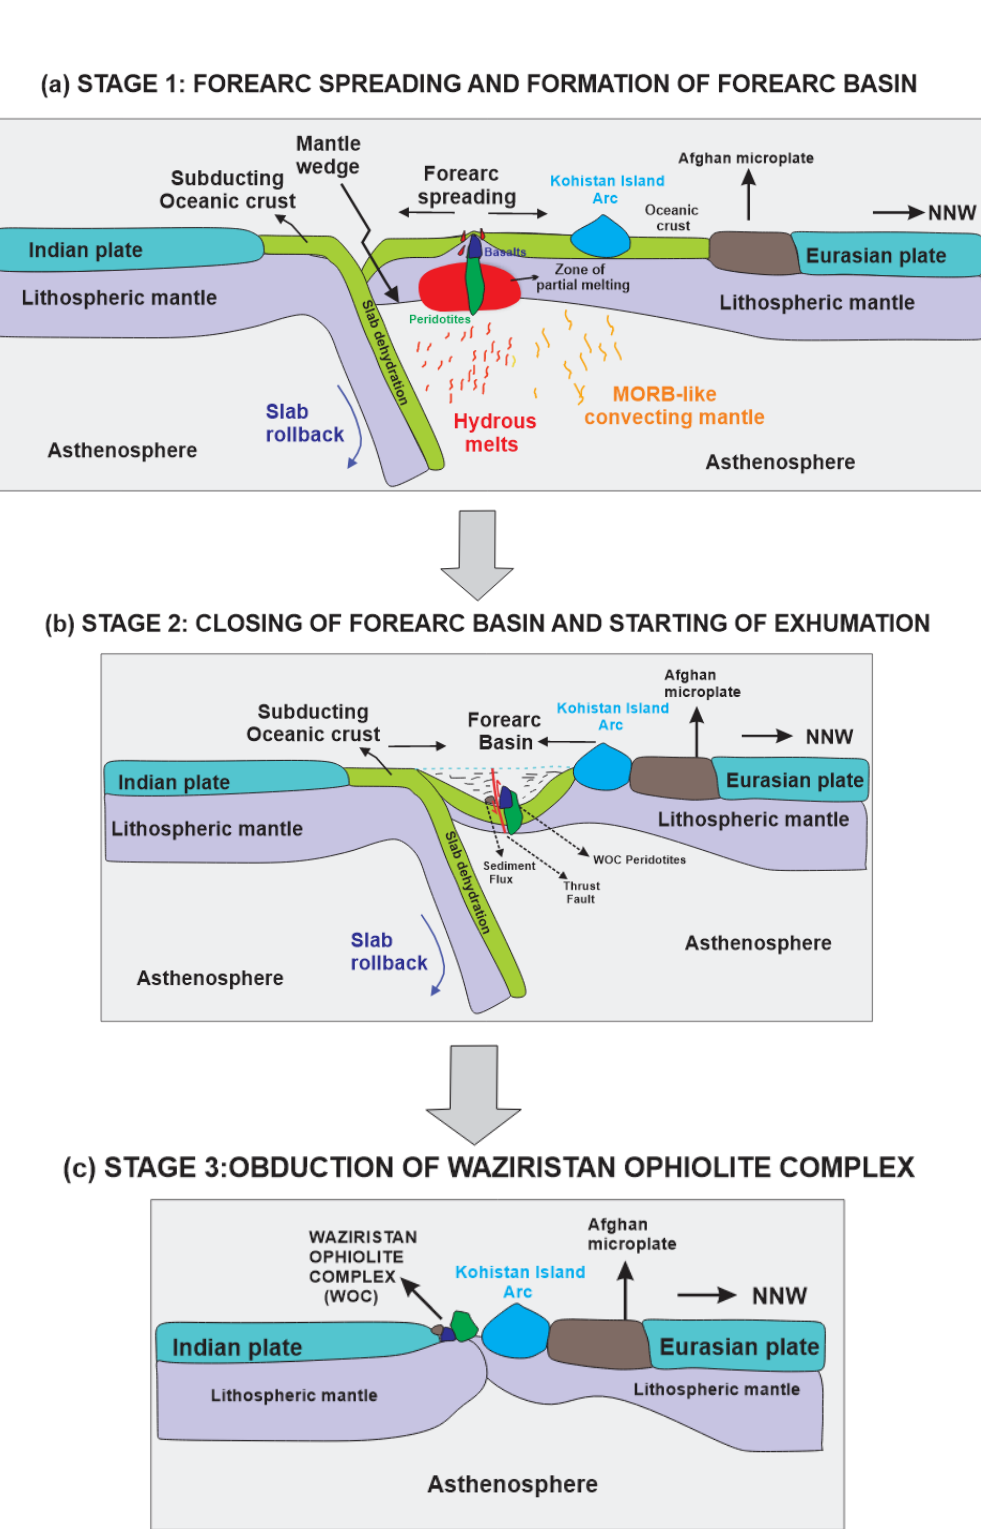
Figure 15. Schematic model (not to scale) showing the formation and emplacement of WOC. ( a ) Formation of WOC peridotites during forearc spreading (subduction initiation); ( b ) closing of forearc basin and exhumation of WOC along the thrust fault; ( c ) obduction of the WOC on the continental crust.